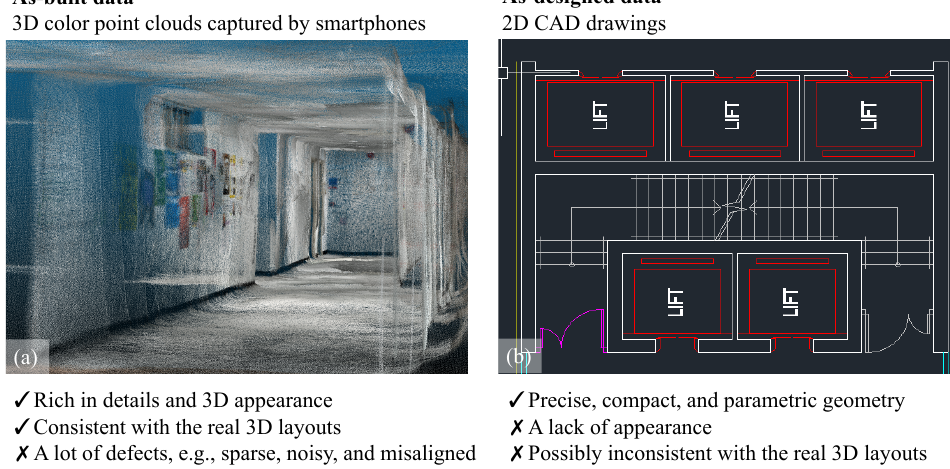
Figure 1. Comparison of two inexpensive data sets for DTBs. ( a ) Smartphone’s colorful 3D point clouds; ( b ) 2D CAD